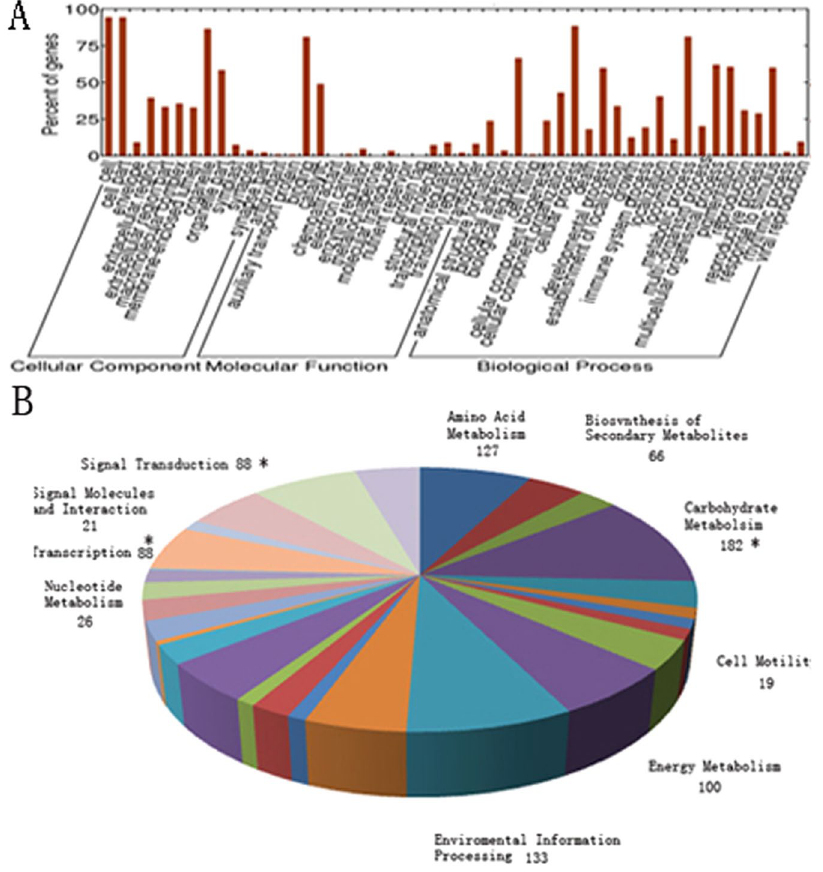
Figure 3. The GO, KEGG analysis of DEUs. ( A ) The GO classification of DEUs. The x-axis indicates the different subcategories, and the y-axis indicates the percent of genes in a subcategory. ( B ) The main KEGG pathways of DEUs. Different colors represent the pathway entries and pathway names, and the number represent the gene numbers in the pathway. The “ * ” represent the enriched